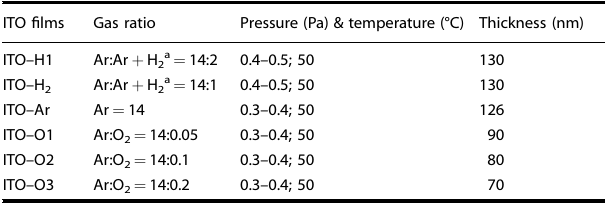
Table 1. The sputtering condition of all ITO and their